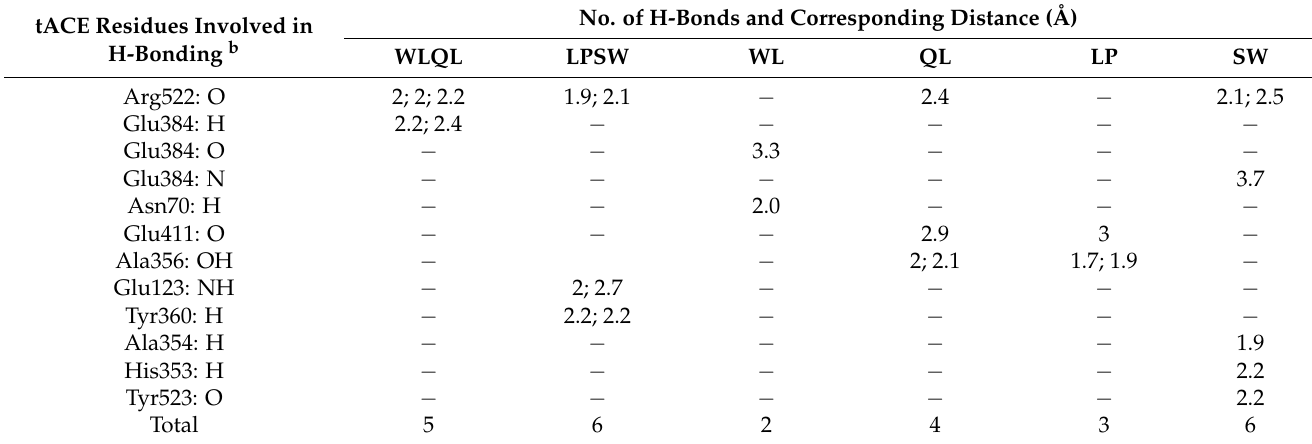
Table 4. Hydrogen bonds observed between the top-ranked docked poses of peptides and tACE a .